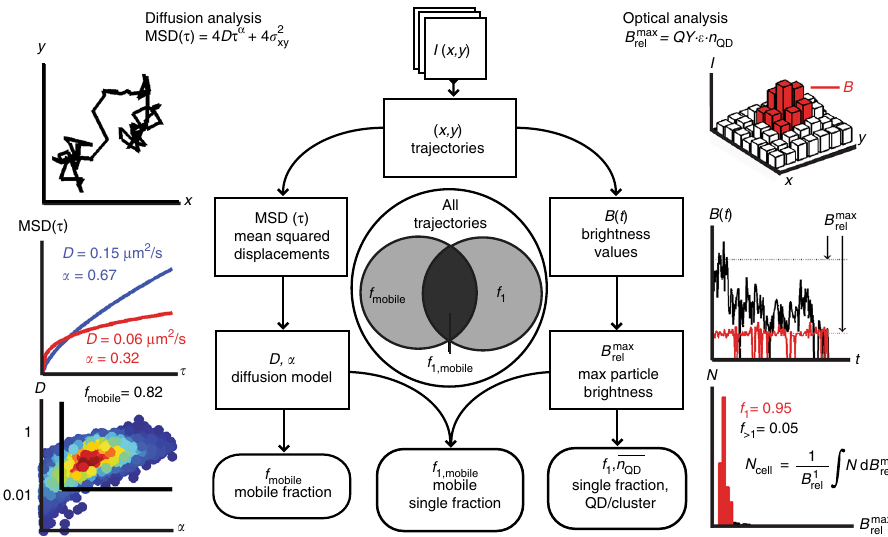
Fig. 3 Analysis methodology for quantam dot mobility and clustering. Single particle trajectories ( x ( t ), y ( t )) are extracted from raw image stacks of I ( x , y ), and each trajectory is analyzed by diffusion and the optical metrics. For diffusion analysis, mean squared displacement (MSD) curves for each trajectory are fi t to an anomalous diffusion model to yield a diffusion coef fi cient, D , and con fi nement parameter, α . These values for each trajectory are aggregated across all cells for a given experimental condition, and thresholds are imposed to determine the mobile fraction, f mobile . Representative data are shown at left and a heat map of D versus α shows an example of a high mobile fraction ( f mobile = 0.82). For optical analysis, the brightness per trajectory at each time point, B ( t ), is analyzed to determine its maximum relative value, B max , to calculate the number of QDs per cluster, n QD . Representative data show intensity rel time traces of a single quantum dot (red) and a cluster (black). The distribution of all B max values for each cell is then analyzed to extract the fraction that is rel single, f 1 , and the average number of quantum dots per cluster, n , is then aggregated across all cells for each experimental condition. Representative data QD show a B max distribution with a high single fraction ( f 1 = 0.95) and low cluster fraction ( f >1 = 0.05). The diffusion and optical analyses are then combined to rel analyze speci fi c particle populations to determine the fraction that are both single and mobile, f 1,mobile , represented in the Venn diagram at the center. Parameters in rectangles are determined for each trajectory, whereas the parameters in rounded boxes are determined for a QD population in one cell